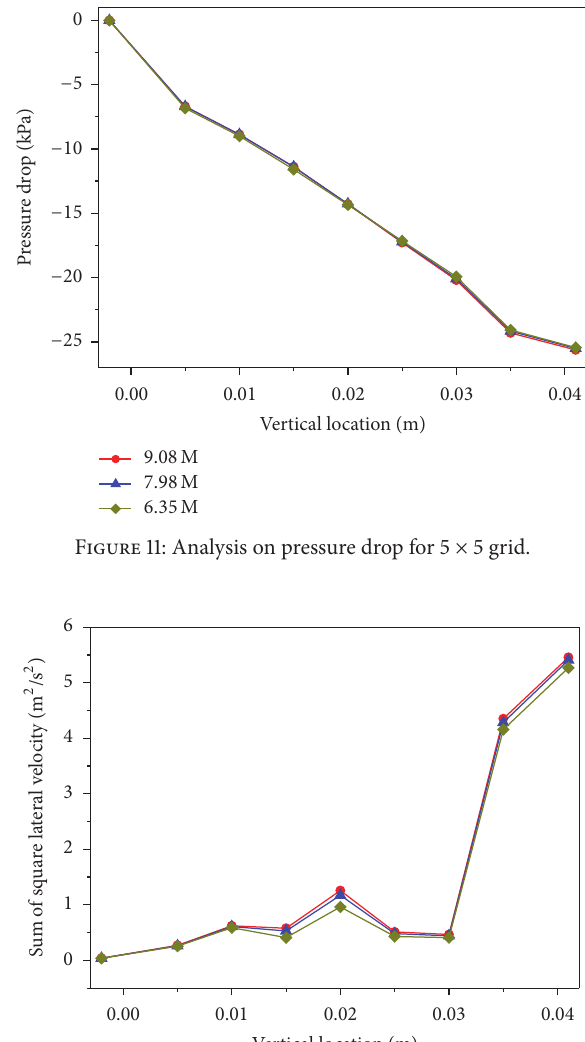
red path line of each section for the comparison was designed as Figure 14. The lateral velocity is normal to the red pathline.